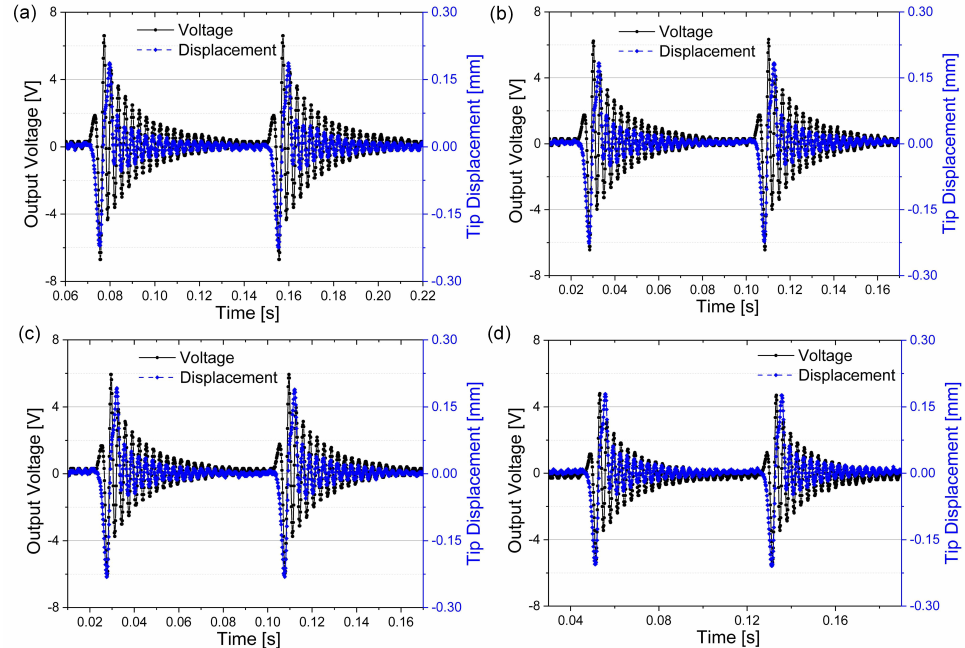
Figure 8. Variation of beam tip displacement and output voltage for different electrode coverage ratios with their optimal resistive loads connected. ( a ) 32.1% (200 k Ω ); ( b ) 54.7% (150 k Ω ); ( c ) 66.1% (130 k Ω ) and ( d ) 100% (100 k Ω ). The driving frequency was 12.5